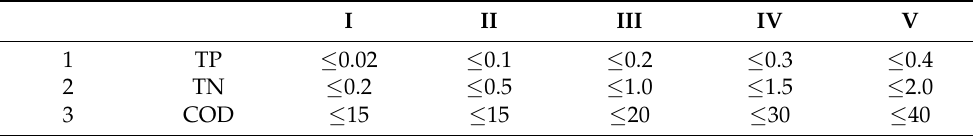
Table 1. Basic item standard limits of surface water environmental quality standard.